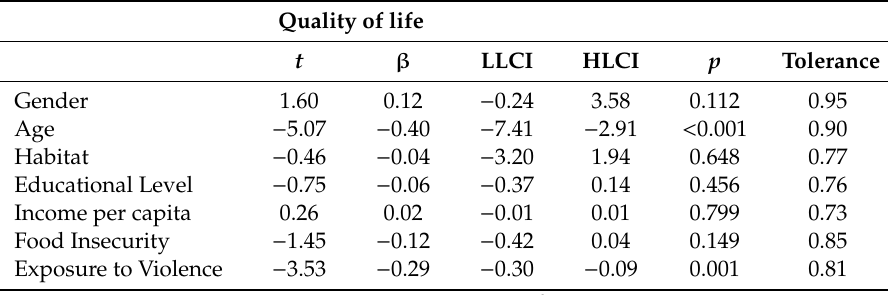
Table 6. Hierarchical regression analysis for quality of